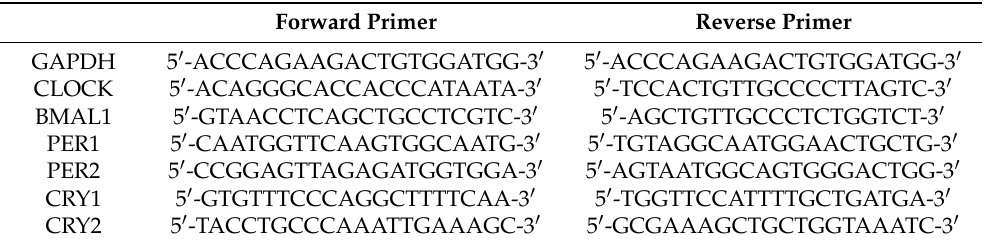
Table 1. Primer sequences used for quantitative real-time PCR